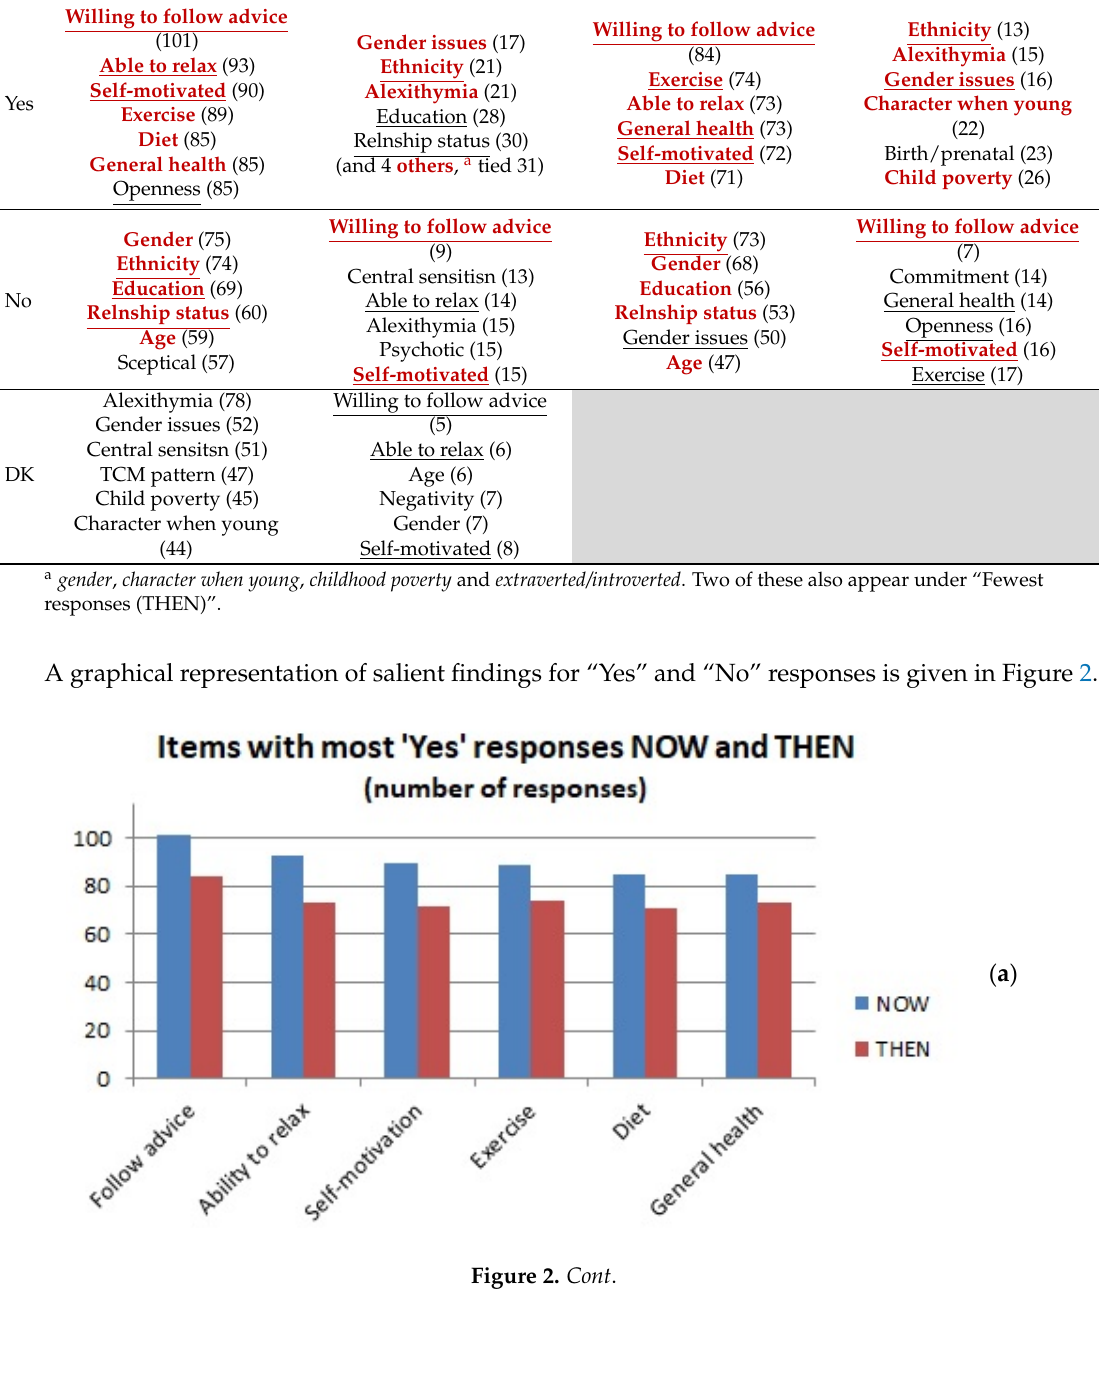
Table 3. “Yes”, “No” and “Don’t know” (DK) responses in the upper and lower deciles for the 60 main survey questions (numbers of responses in brackets). Items shown in bold red type appear in the same deciles both NOW and THEN; those underlined appear in Most “Yes” responses and Least “No” responses (NOW or THEN), or vice versa.